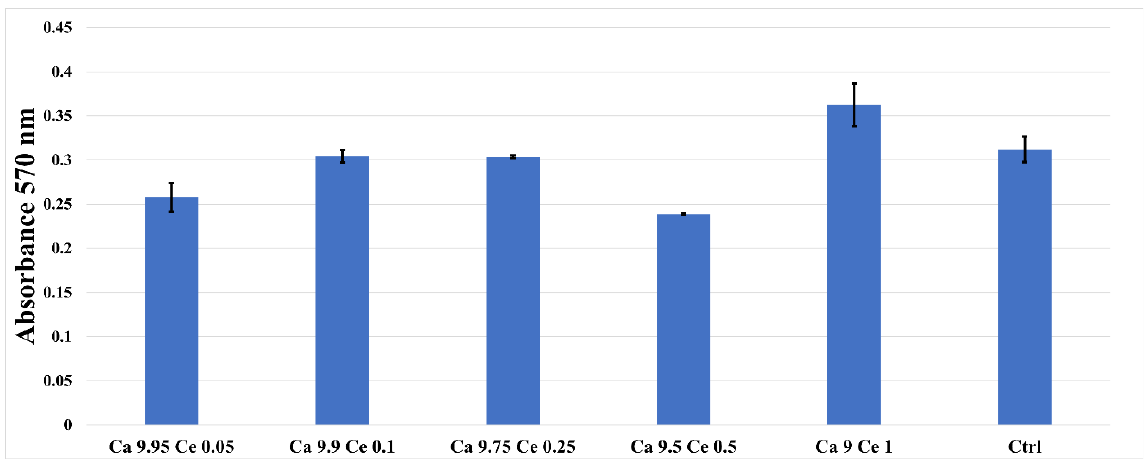
Figure 9. MTT assay showing the viability of AFSC in the presence of the cerium-doped HAp nanomaterials and control (cell only).